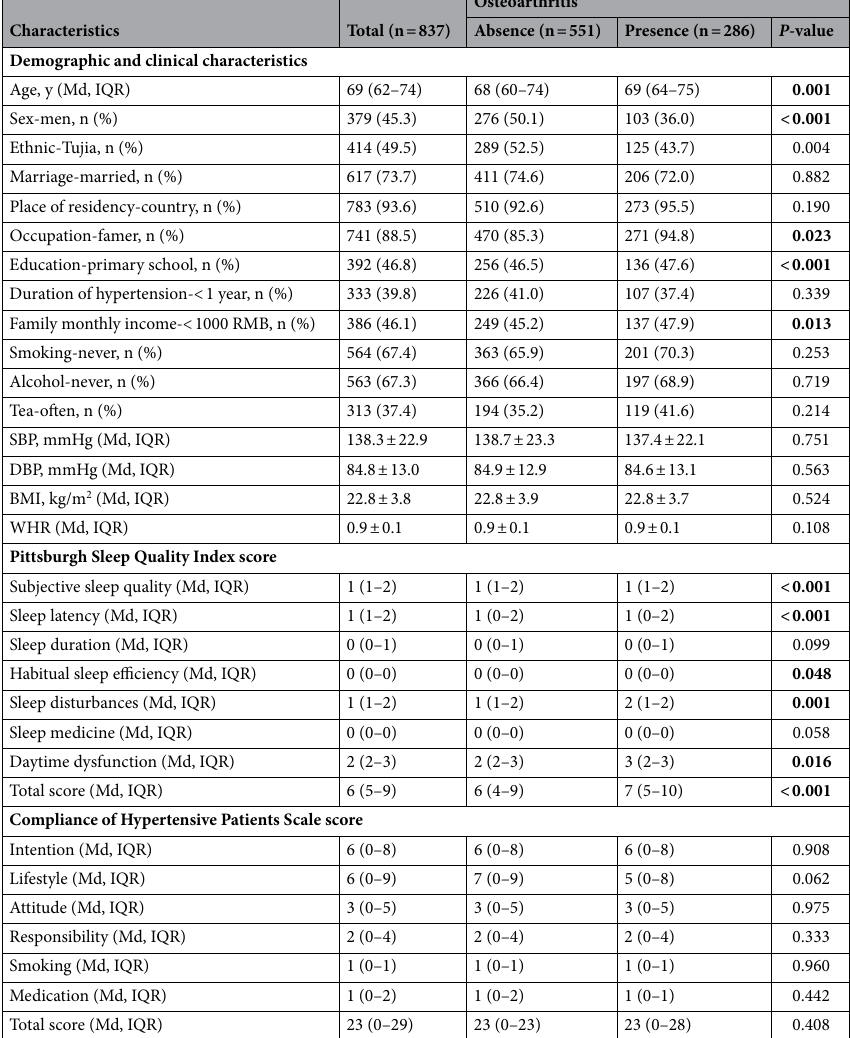
Table 1. Participants’ characteristics according to OA status stratification. Md median, IQR interquartile range, SBP systolic blood pressure, DBP diastolic blood pressure, BMI body mass index, WHR waist-to-hip ratio. Significant differences ( P < 0.05) are highlighted in